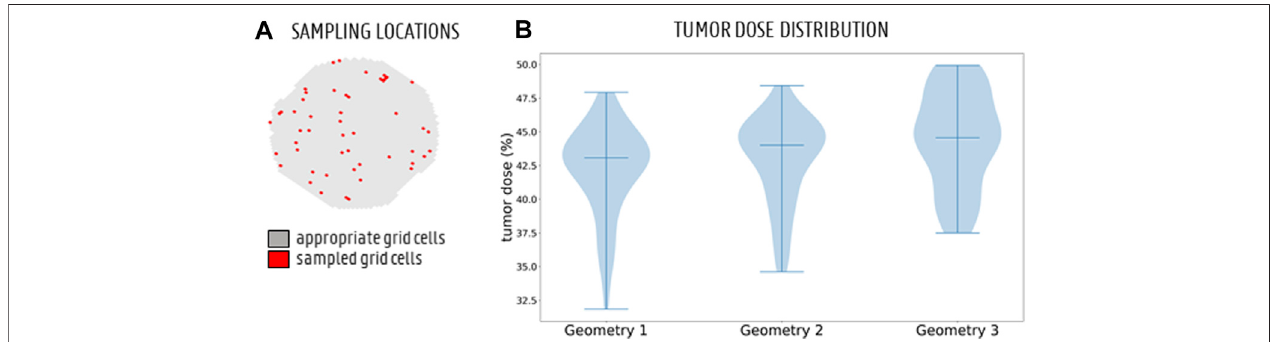
FIGURE8|(A) Thefullsamplingsetofappropriategridcells(grey)and50sampledgridcells(red)tosimulateparticleinjectionfromthesecathetertiplocations. (B) Monte Carlo distribution of tumor dose (TD) for 50 randomly sampled catheter injection locations in each geometry. The 3 bars denote the minimum, median and maximum, respectively. The violin plot for Geometry 3 looks slightly different than for Geometries 1 and 2, but the medians are very similar.